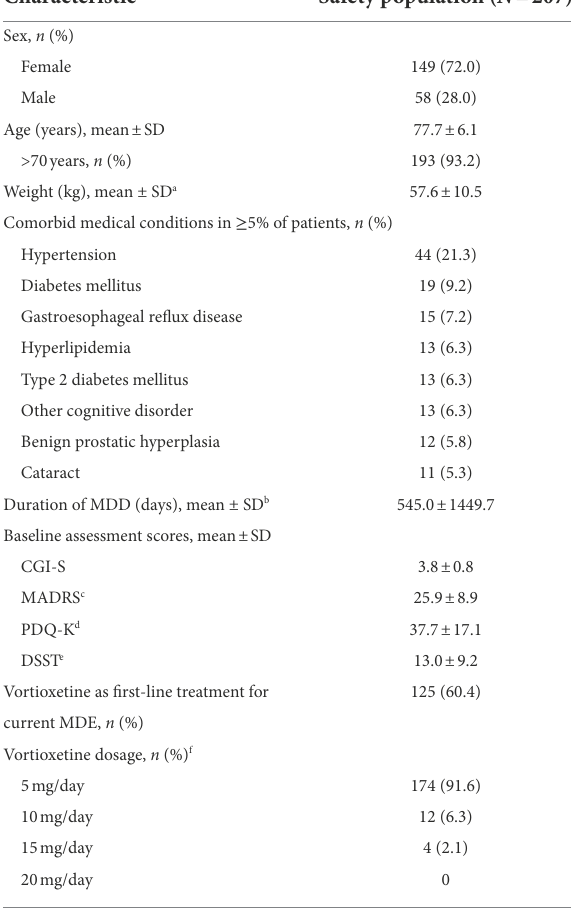
TABLE 1 Patient demographic and clinical characteristics at baseline (safety analysis